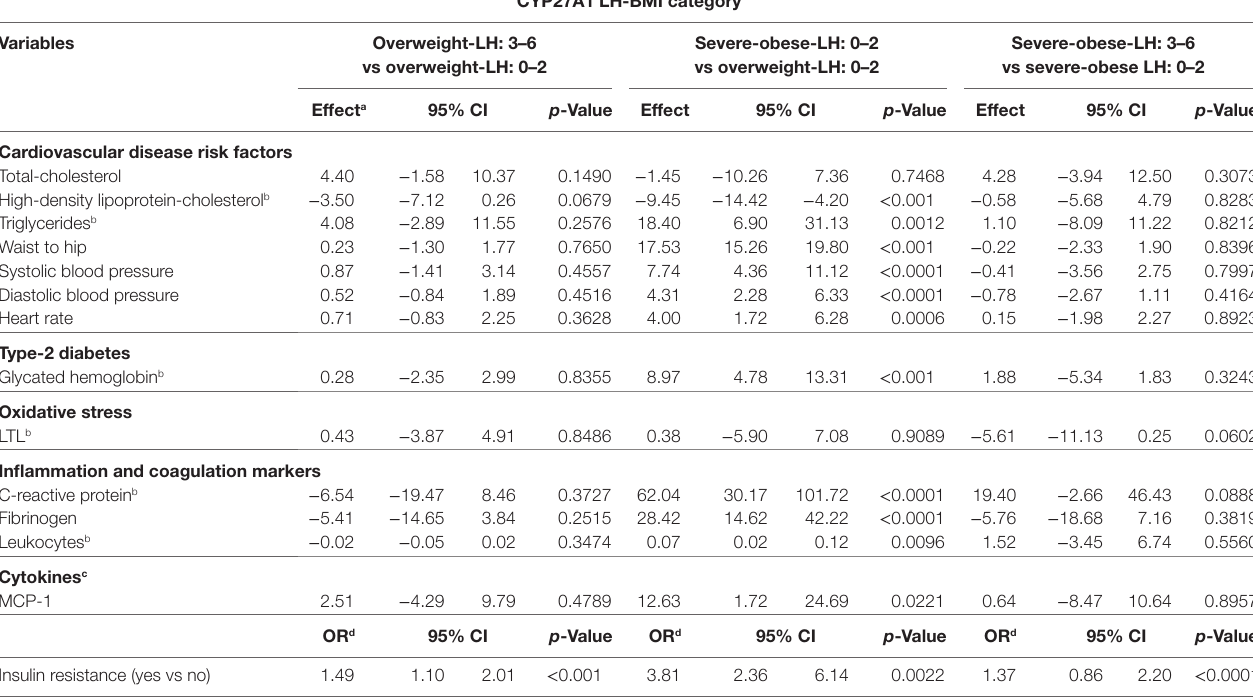
TaBle 3 | Univariate analysis.